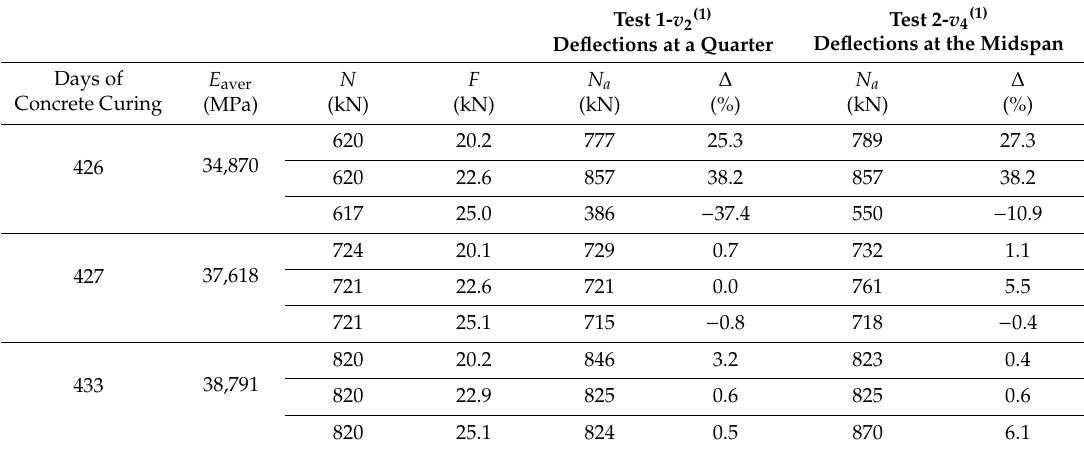
Table 4. Prestress force determinations N a based on Equation (8a) (Test 1) and Equation (8b) (Test 2), and corresponding measured parameters for each test day [80]. Copyright © 2018, World Scientific Publishing Co. Pte Ltd. Adapted with permission. Test 1- v